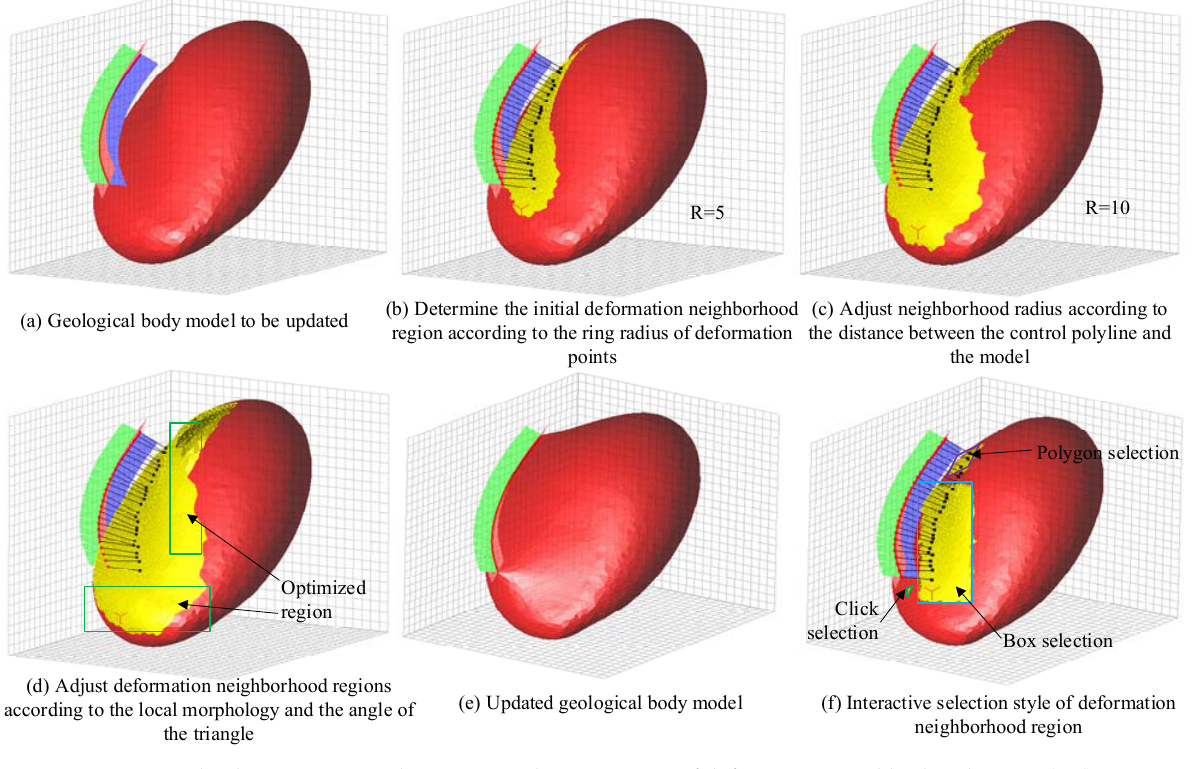
Figure 7. The determination, adjustment, and optimization of deformation neighborhood region ( a – f ).